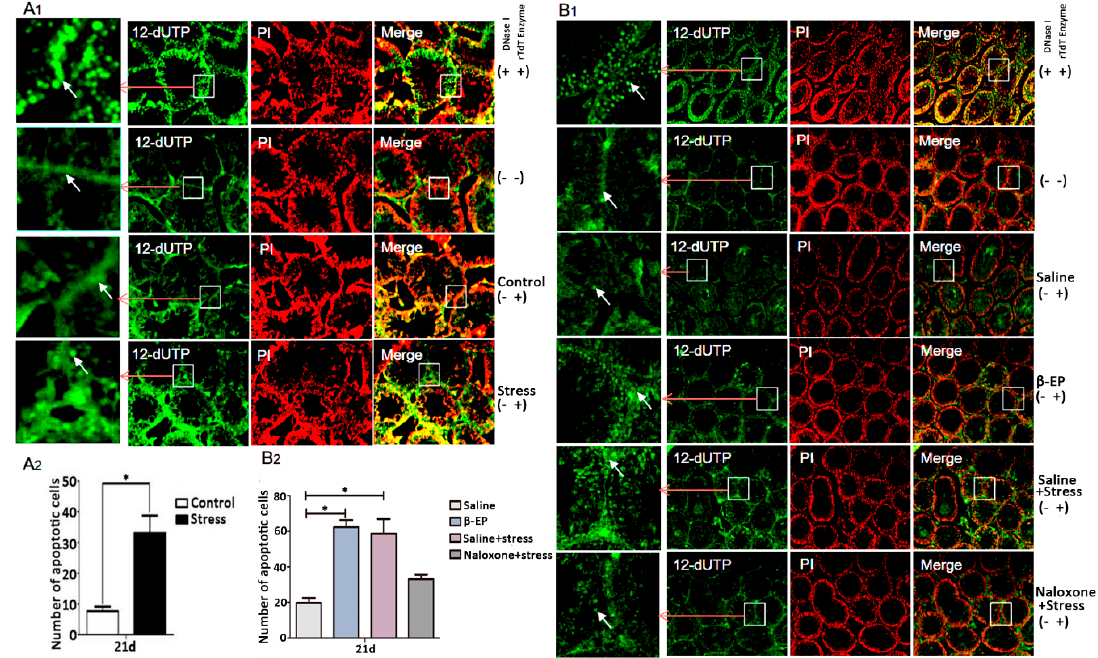
Figure 3. PS induces cell apoptosis in testis. ( A1 , A2 ) PS increased apoptosis of LCs and spermatogenic cells in testis of PS rats vs. controls at day 21 as evidenced by TUNEL staining. Apoptotic cells were shown in green positive areas (indicated by white arrows). The number of apoptotic cells was counted using ImageJ 2.0. ( B1 , B2 ) β -EP injection increased and naloxone reversed testicular cell apoptosis. Whether added DNase I / rTdT Enzyme or not was indicated by “ + ” and “ −